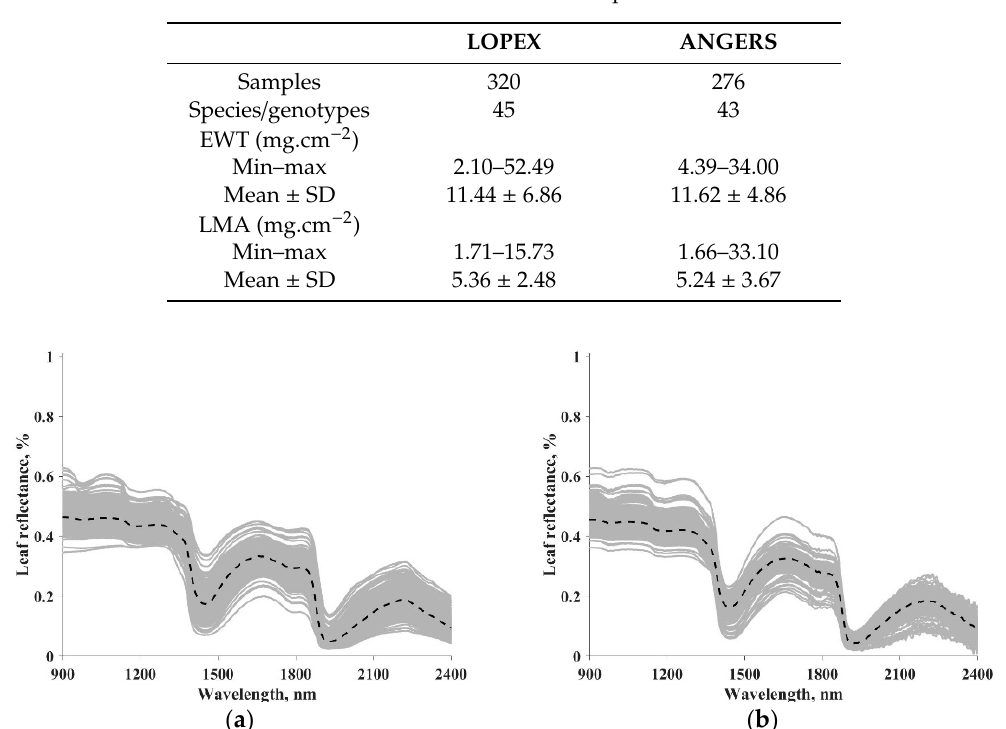
Table 1. Statistical characteristics of the experimental datasets.